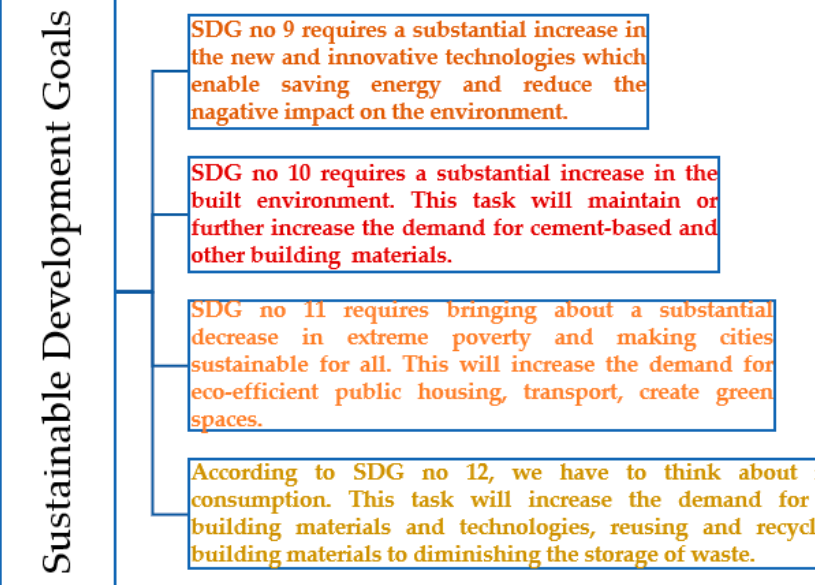
Figure 1. Correlation between selected sustainable development goals and development pathways in construction.